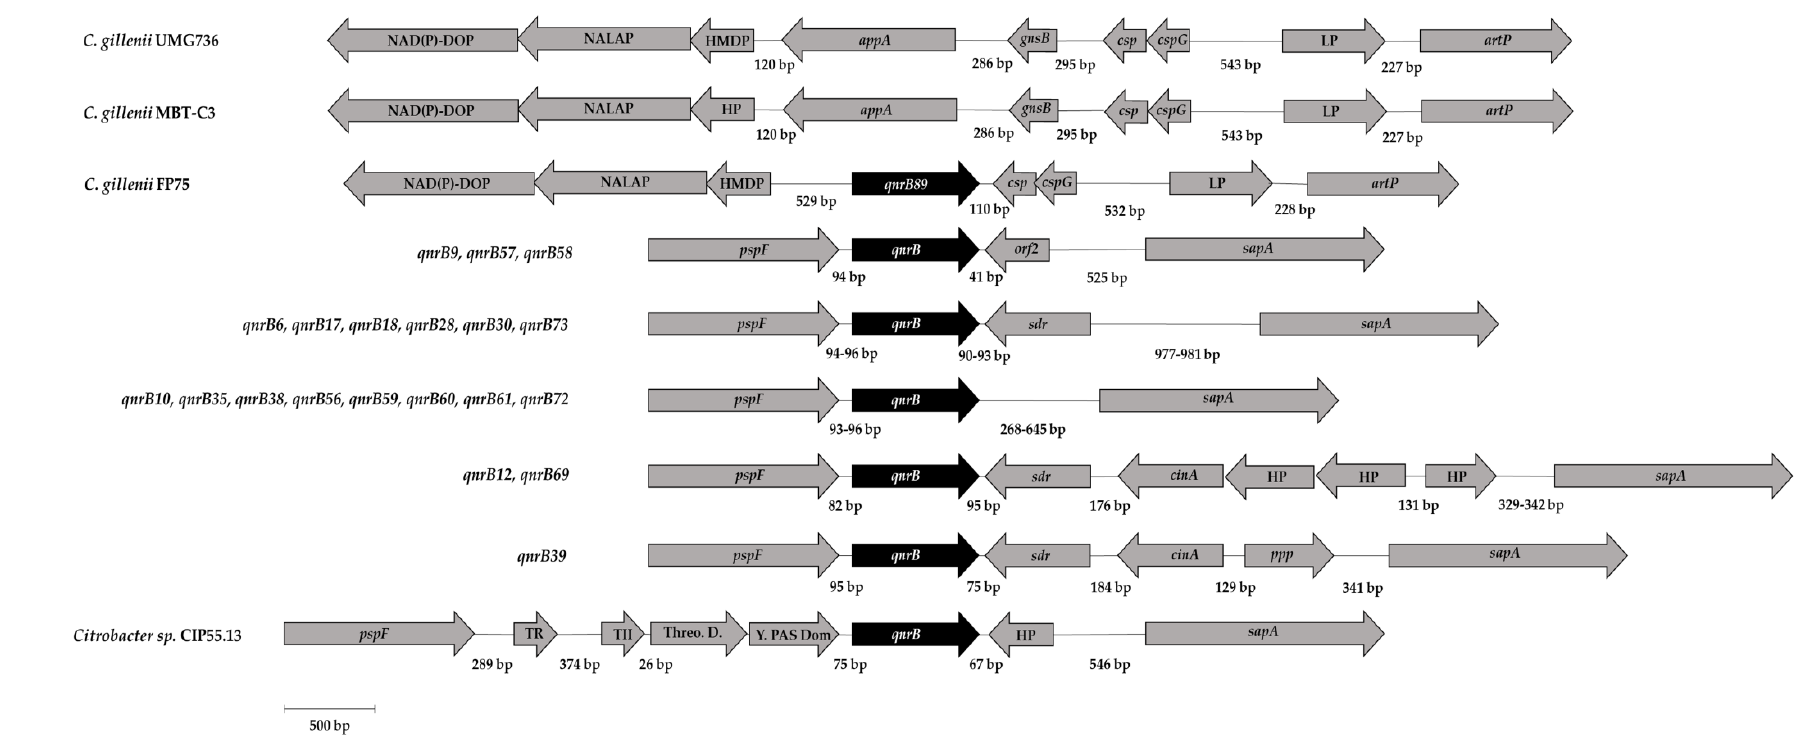
Figure 2. Comparison of the genetic environment of the gene qnrB89, Schematic representation of the genetic environment of qnrB89 gene carried by Citrobacter gillenii FP75 with several chromosomally located qnrB genes carried by various Citrobacter species as described by Ribeiro et al. [28]. Numbers between ORFs indicate the size of the intergenic region in base pairs (bp). The sequences used in the scheme were those previously considered by Ribeiro et al. [28], and include the GenBank accession numbers KP339254 (qnrB6), KP339255 (qnrB9), ADLG01000026.1 (qnrB9), KP339256 (qnrB10), CP007557 (qnrB12), KP339257 (qnrB17), KP339258 (qnrB18), ACDJ02000027.1 (qnrB18), JTBV01000001.1 (qnrB28), JMUJ01000007.1 (qnrB28), JAPA01000008.1 (qnrB30), JN173057 (qnrB35), JN173060 (qnrB38), NZ_AMPE01000004.1 (qnrB38), NZ_AKTT01000018.1 (qnrB38), NZ_AOUE01000004.1 (qnrB38), JTBJ01000001.1 (qnrB38), JAPB01000002.1 (qnrB38), ABWL02000005.1 (qnrB39), KP339259 (qnrB56), KP339260 (qnrB57), KP339261 (qnrB58), KP339262 (qnrB59), AB734055 (qnrB60), AB734053 (qnrB61), BBMW01000005.1 (qnrB69), KP339263 (qnrB72), KP339264 (qnrB73), and CDHL01000019, corresponding to a new qnrB from strain CIP 55-13T, as described by Ribeiro et al. [28]. In addition, similar locus found in two available C. gillenii genomes belonging to the not-carrying qnr genes strains C. gillenii UMG736 (SUQN00000000.1) and C. gillenii MBT-C3 (QVEK00000000.1), are included in the scheme.